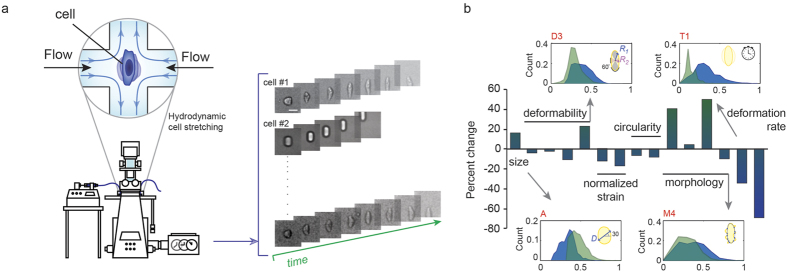
Comprehensive high-throughput quantification of cell physical properties.(a) Single cells in suspension are injected into a microfluidic device and are imaged while passing through a hydrodynamic stretching region. Several parameters are extracted from the image series captured from each cell. (b) The percent changes in median values of populations of hESCs (blue) and 14 day differentiated hESCs (green) are plotted for 15 parameters extracted from the image series. Histograms of >1000 single cells per condition are shown for select parameters, indicating substantial overlap in population characteristics when only considering a single parameter. (D3: Maximum deformability at the junction, A: Initial cell size, T1: Total deformation time, M4: Morphology metric extracted during deformation defined by the number of intersections of the trace and the moving average or the cell border).